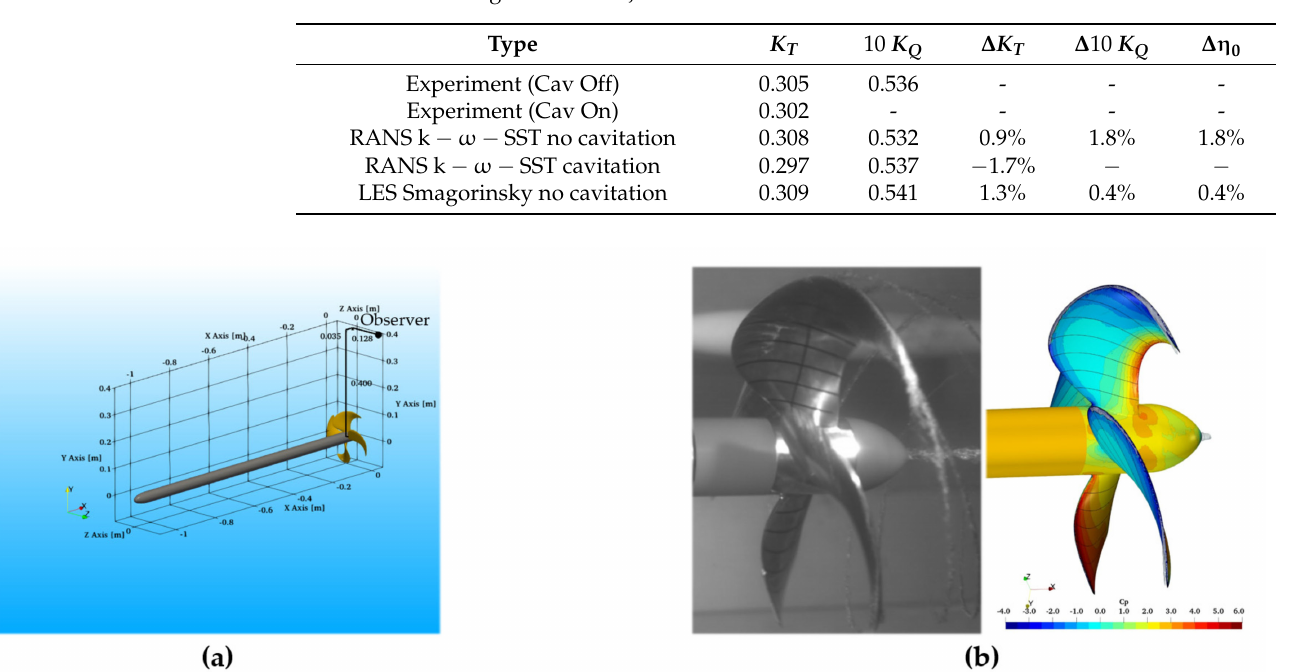
Figure 6. P1595. Acoustic investigation: ( a ) numerical setup with pressure observer; ( b ) cavitation